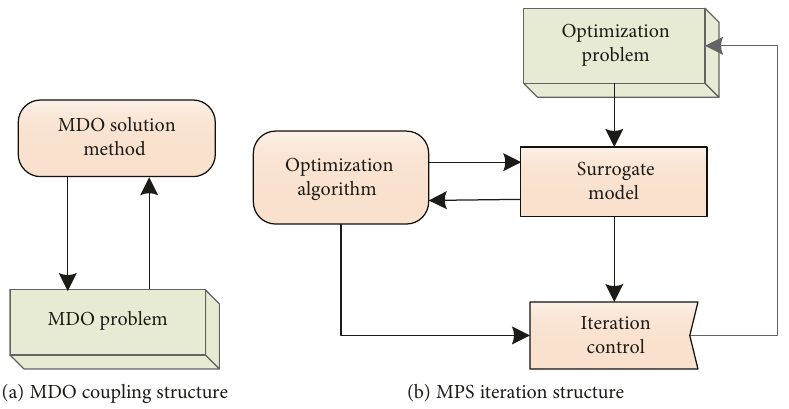
Figure 1: The comparison of MDO coupling structure and MPS iteration